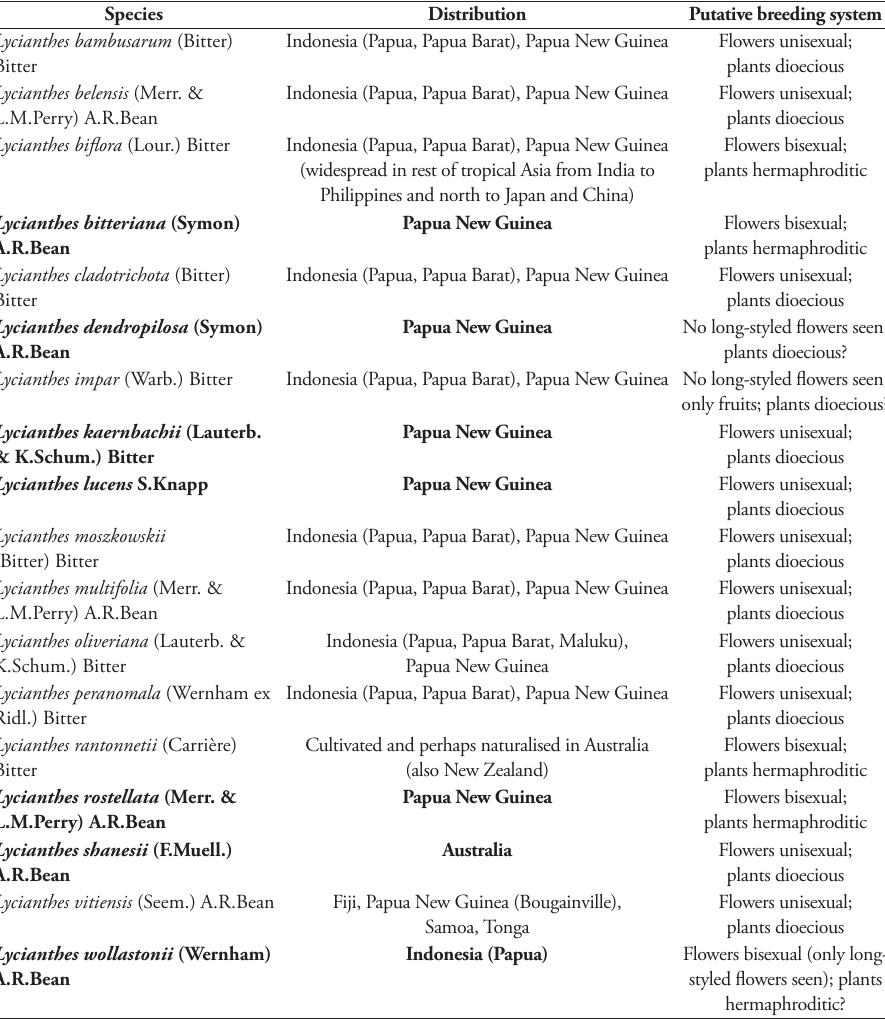
Table 2. Lycianthes species in Australia, New Guinea and the Pacific with their distribution and putative system (see text for discussion of breeding systems). Species endemic to a single country are indicated in bold face